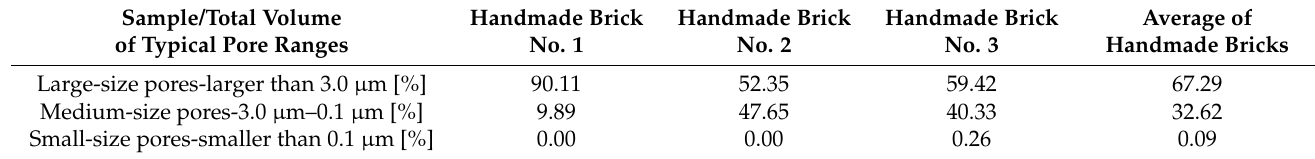
Table 5. The pore size ranges of handmade